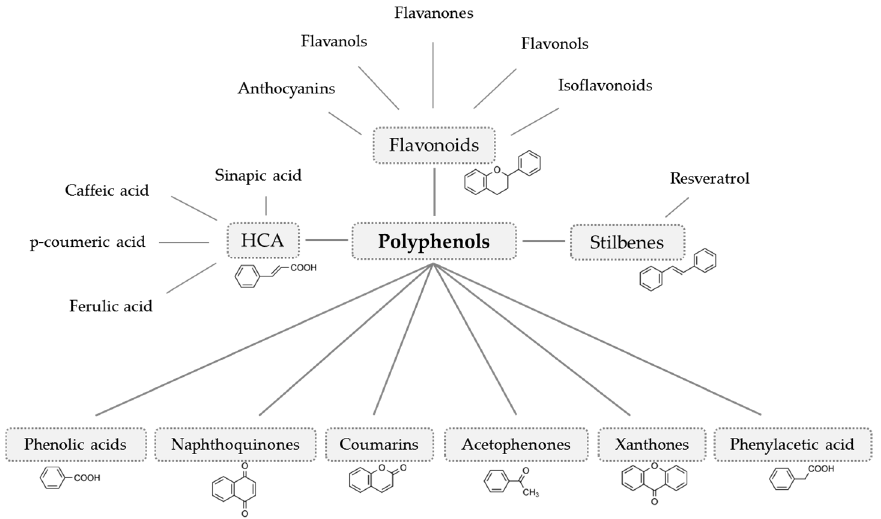
Figure 2. Polyphenol classification (modified from Crozier et al. [51]) The nine polyphenol subgroups are classified according to their chemical structure and are found throughout the plant kingdom. HCA, hydroxycinnamic acids